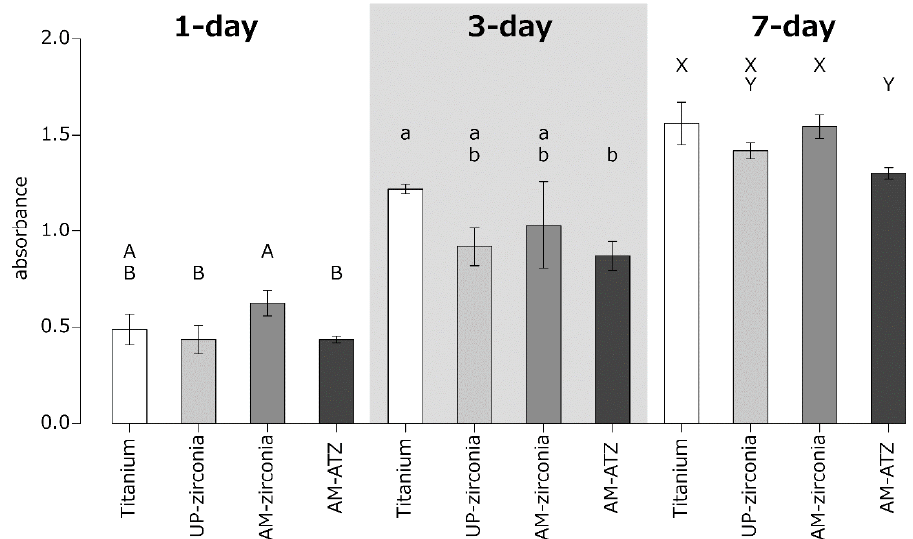
Figure 3. Viability of MC3T3E-1 cells on each material at 1, 3, and 7 days. Identical letters indicate no statistical difference.